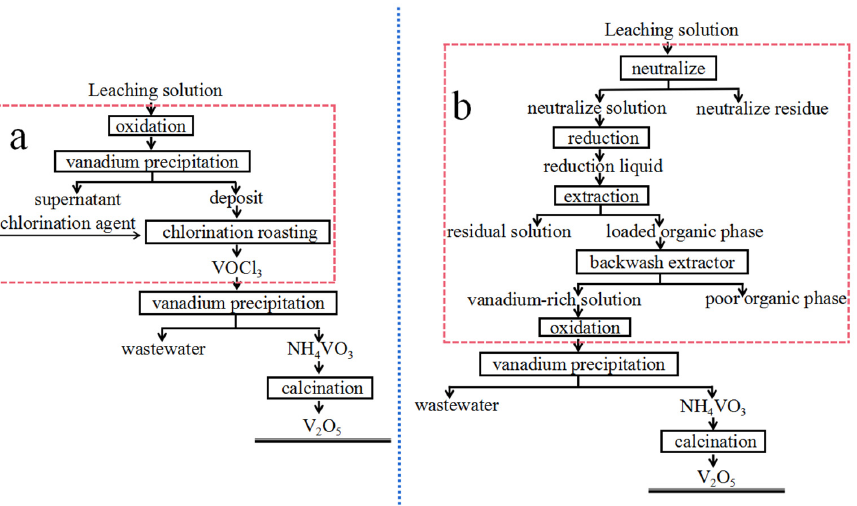
Figure 15. V 2 O 5 preparation process fl ow charts of ( a ) newly developed and ( b ) traditional methods.